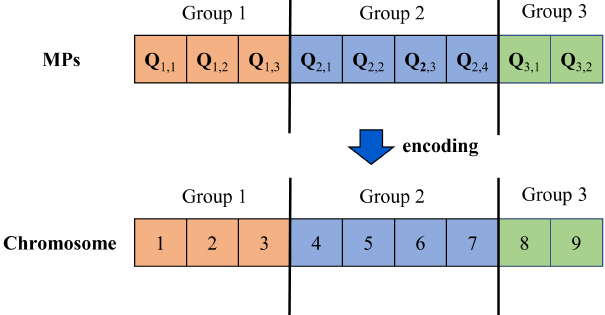
Figure 6. Schematic of the encoding process.